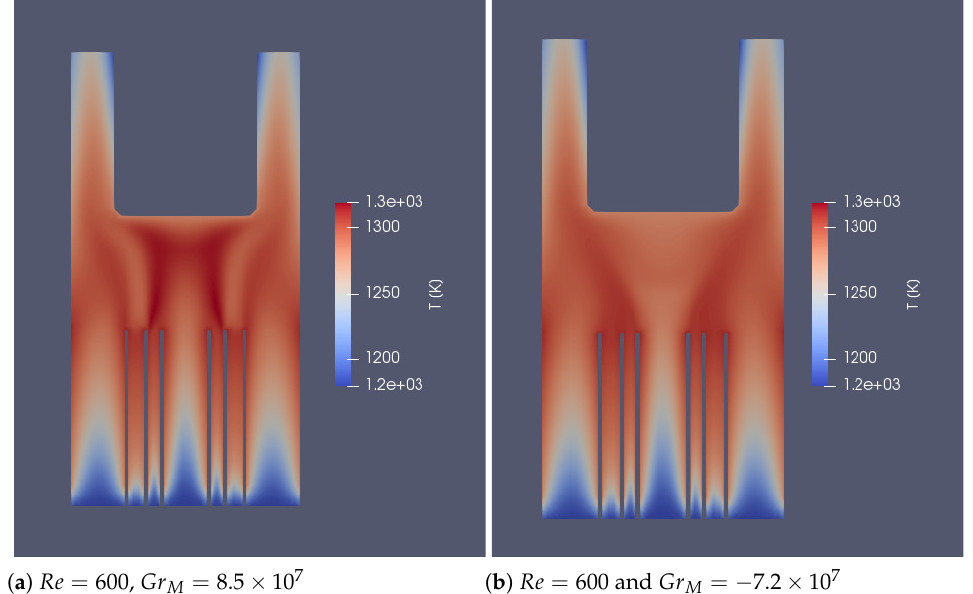
Figure 12. Vertical cut through the up-flow reactor depicting the temperature distribution. ( a ) Varia- tion of NH 3 in the ORL. ( b ) Variation of H 2 in the